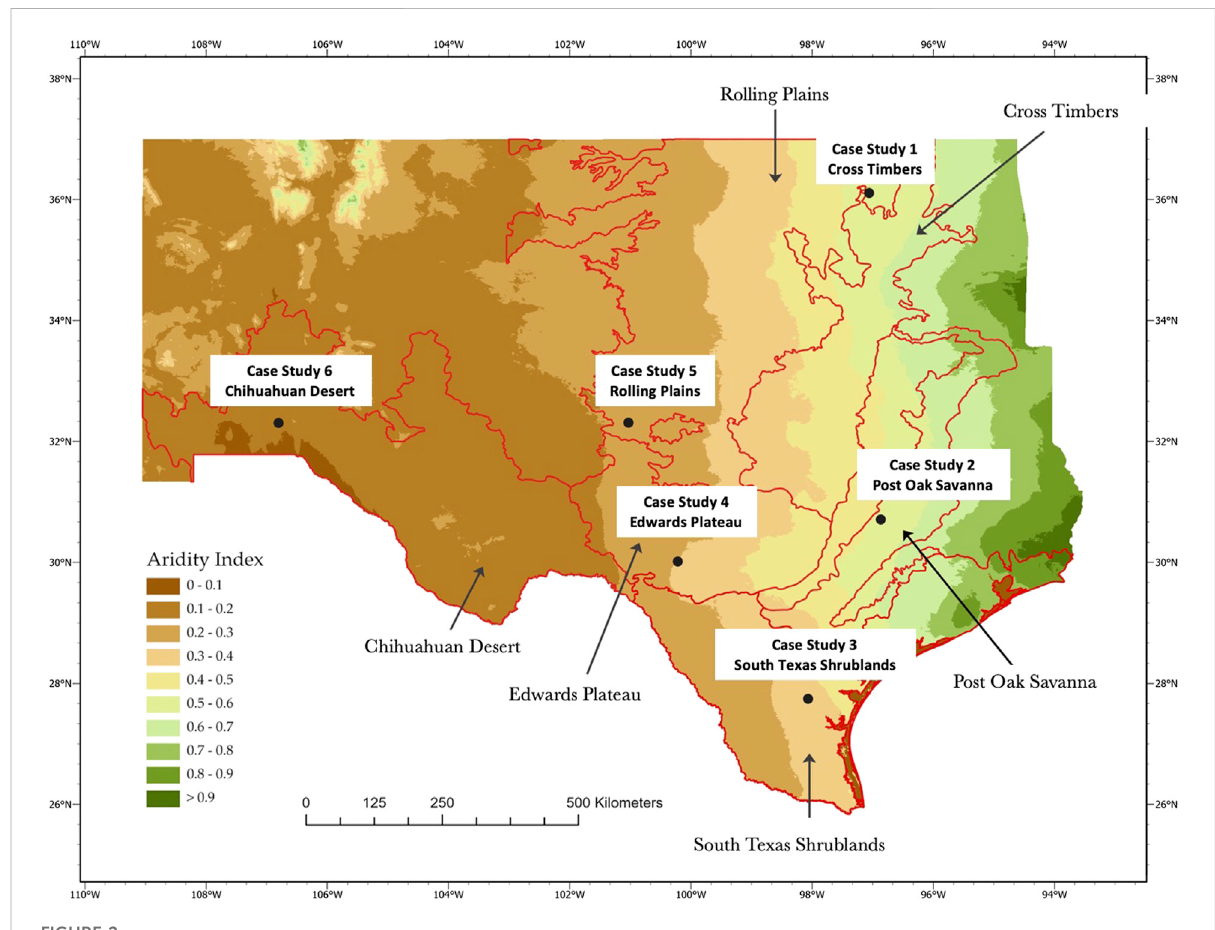
FIGURE 2 Locations of the six study sites within the ecoregions represented by the six case